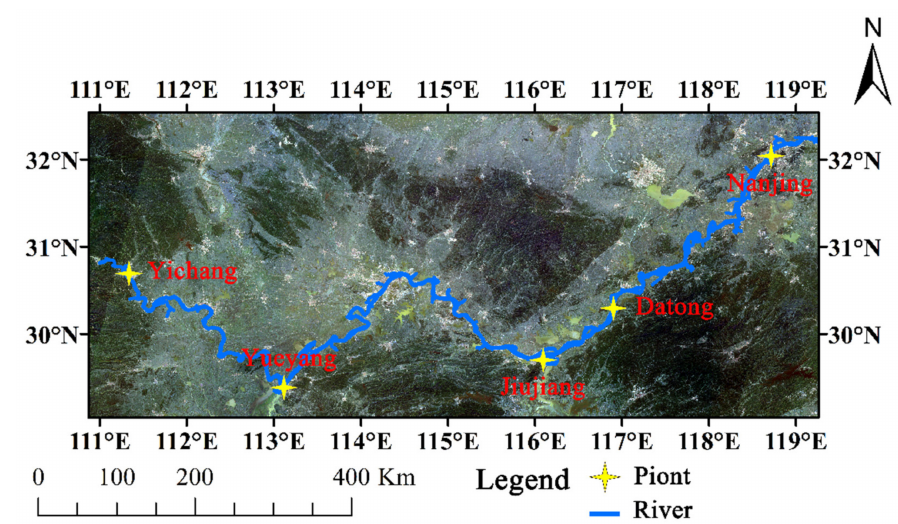
Figure 2. Location of the in-situ measurement sampling